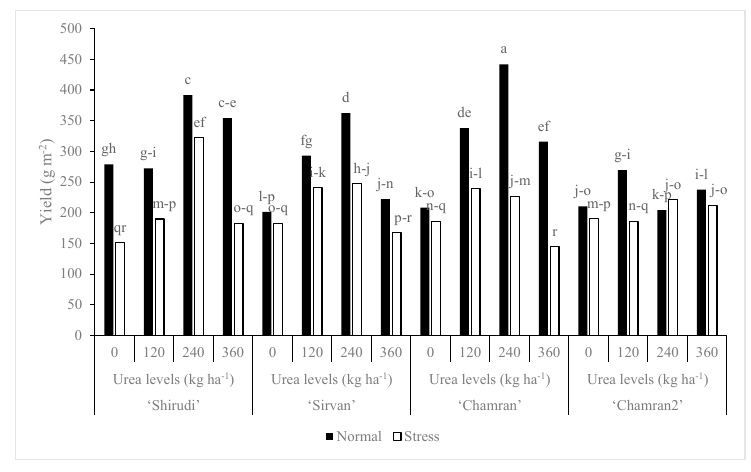
Fig. 4 Interaction effects of location, irrigation, cultivar, and urea levels on seed yield. Mean values with the same letters are not significantly different at p ≤ 0.05 according to Duncan’s